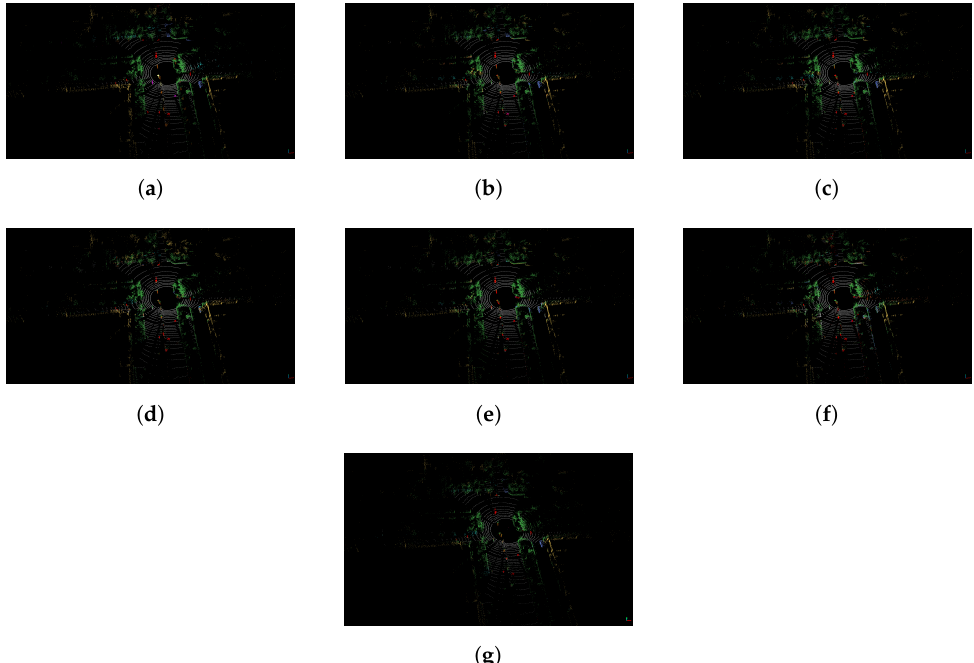
Figure 7. Semantic segmentation results of the SemanticPOSS dataset are presented as point